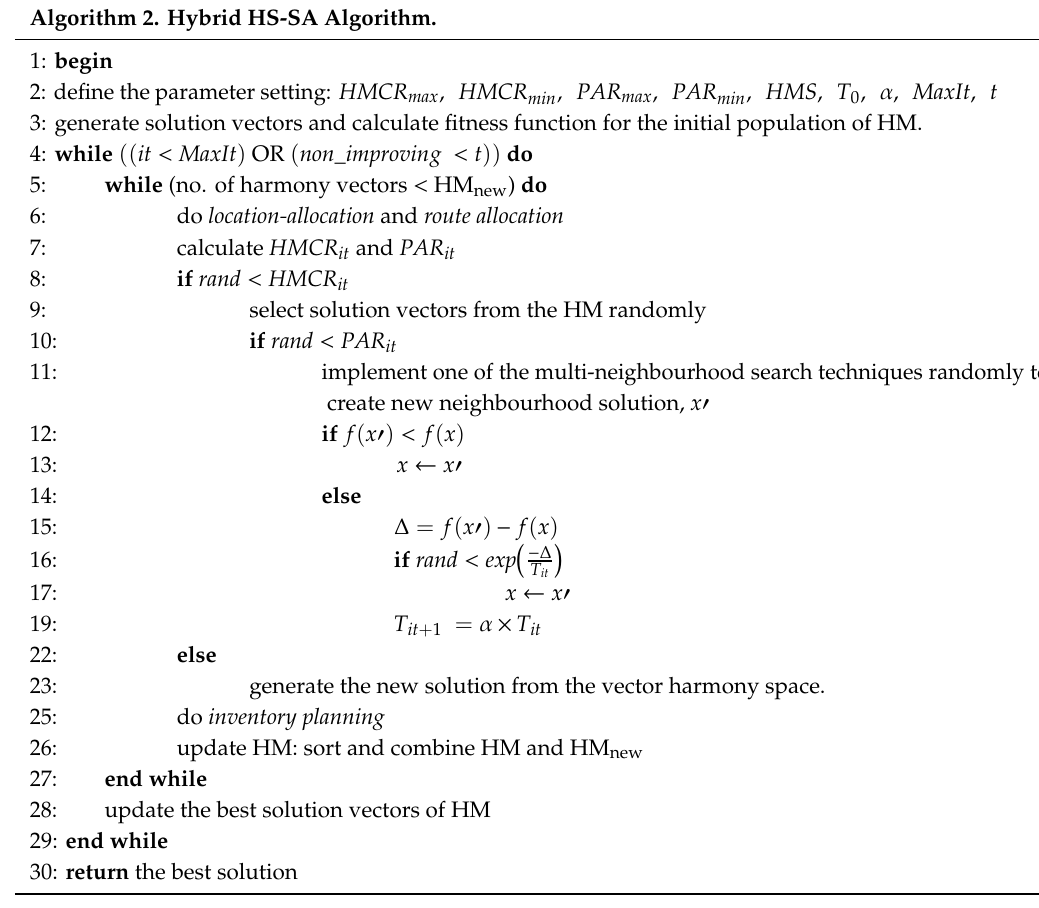
Algorithm 2. Hybrid HS-SA Algorithm.